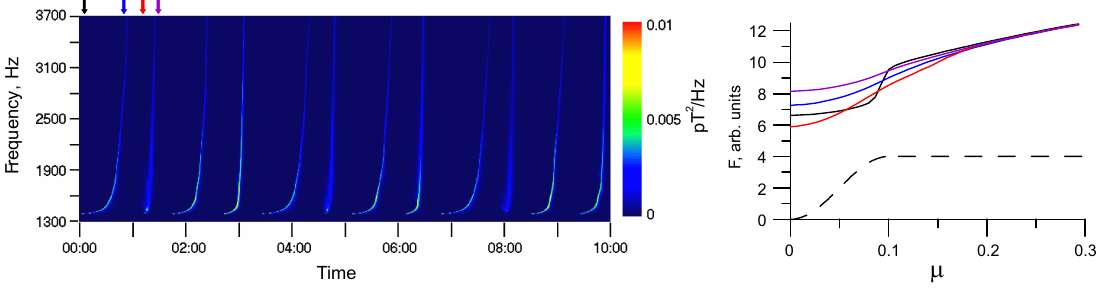
Fig. 5. Periodic generation of wave intensity spikes in the case of losses due to drift with intermission of spikes of two different shapes. The source of energetic particles is 4 times greater than in Fig. 4 ( n hL = 0 . 16 cm − 3 ); all other parameters are the